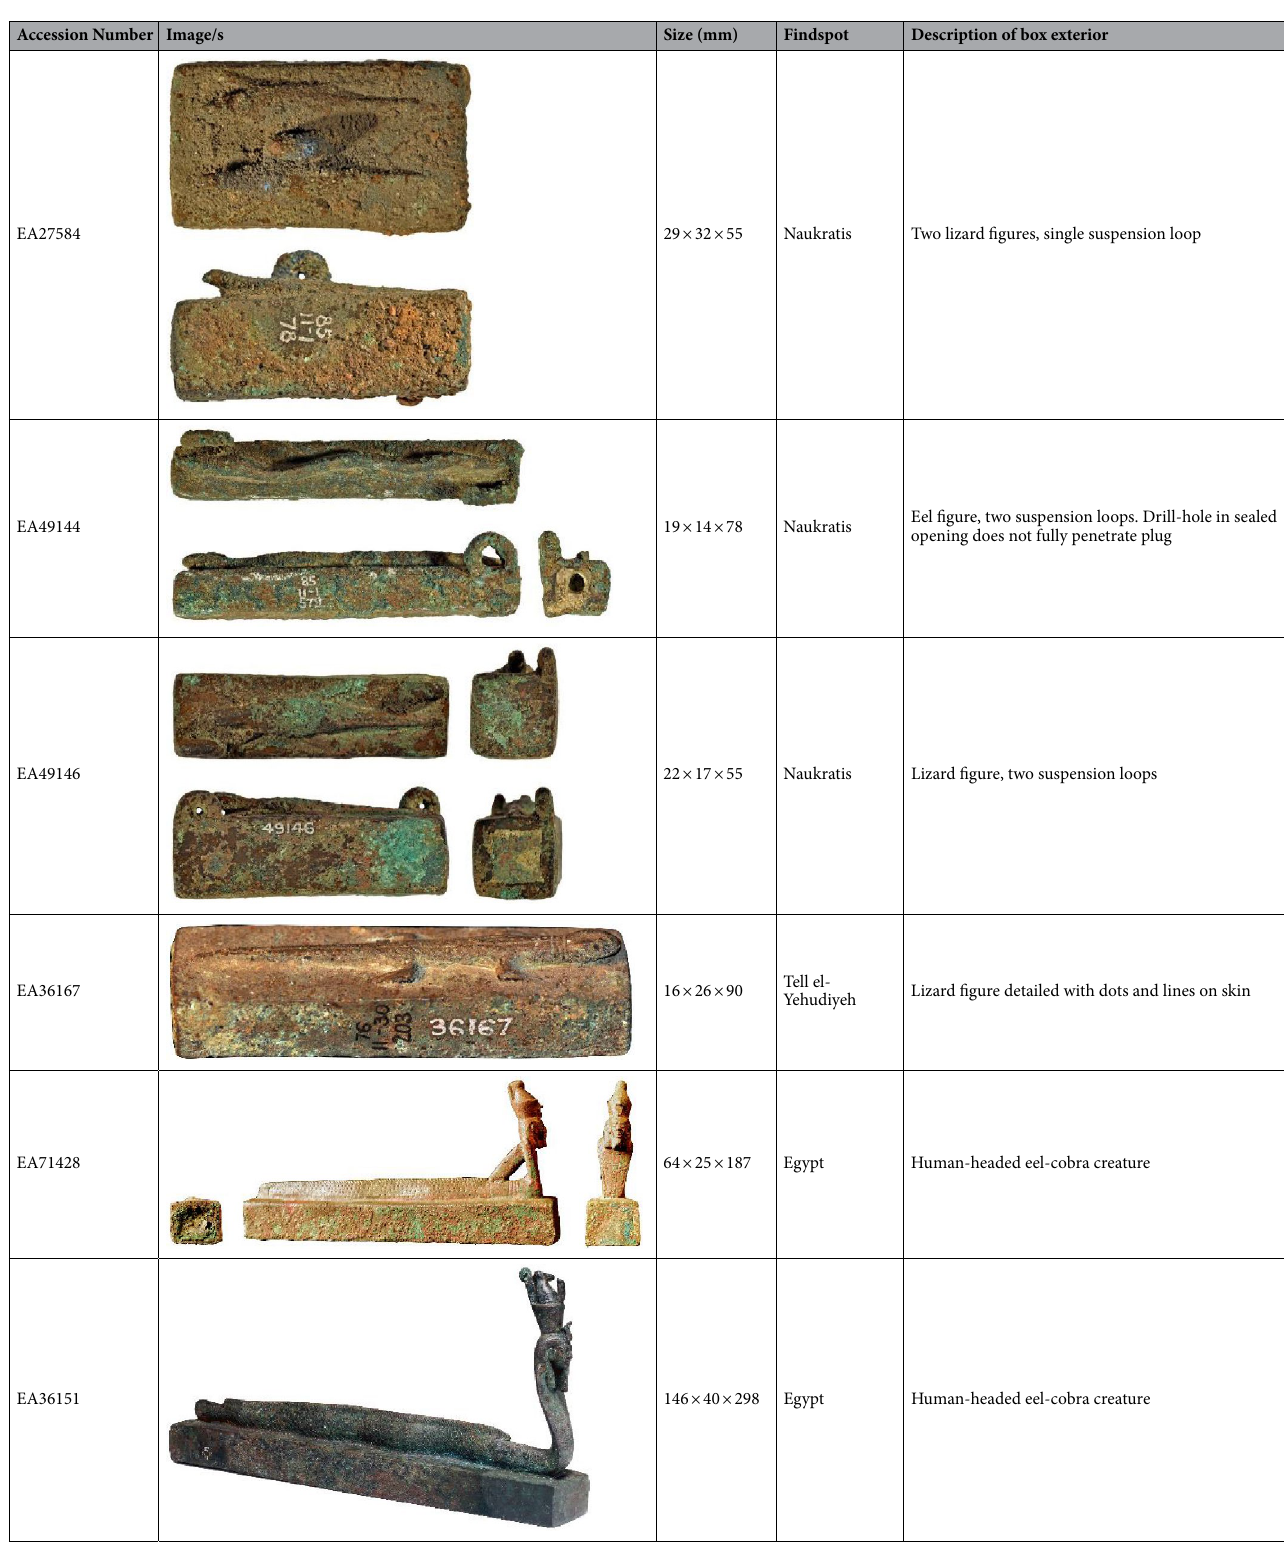
Lizard figure detailed with dots and lines on